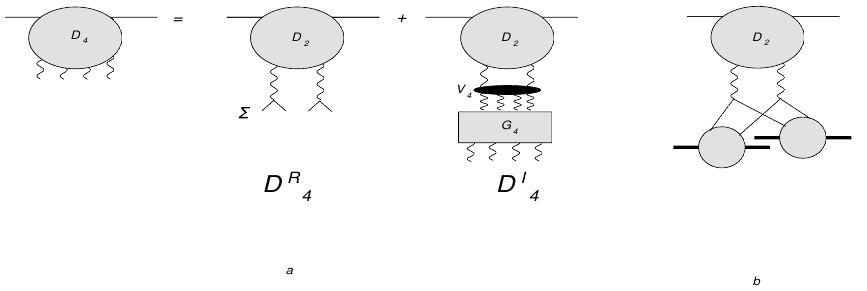
Figure 6 . (a) Amplitude with 4 reggeized gluons: decomposition into reggeized (left) and irre- ducible (right) pieces. The detailed form of the reggeized part, D 2 , is given in 2.19). It is the just the BFKL pomeron where each lower leg carries sums of momenta and (cid:12)nally splits into elementary gluons. (b) Example of the coupling of a reggeized term to two